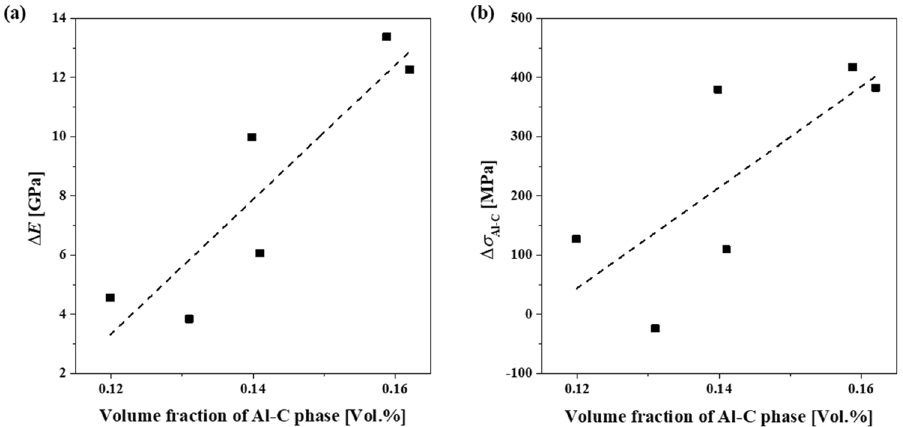
Figure 8. Variation of the difference in ( a ) elastic modulus and ( b ) hardness as a function of volume fraction of Al-C